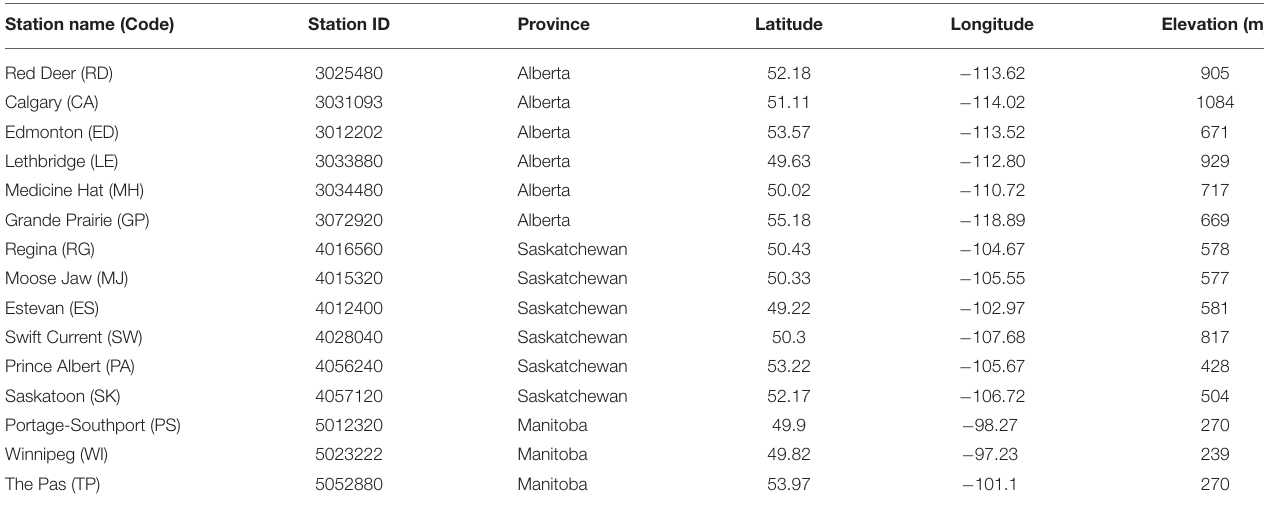
TABLE 1 | Climate stations with location and